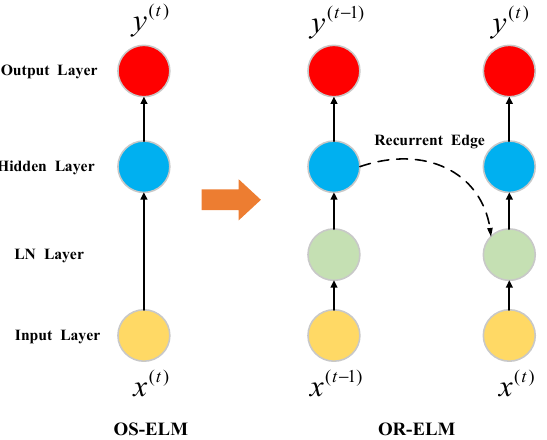
Figure 1. A simple online sequential extreme learning machine (OS-ELM) model and a simple online recurrent extreme learning machine (OR-ELM) model.